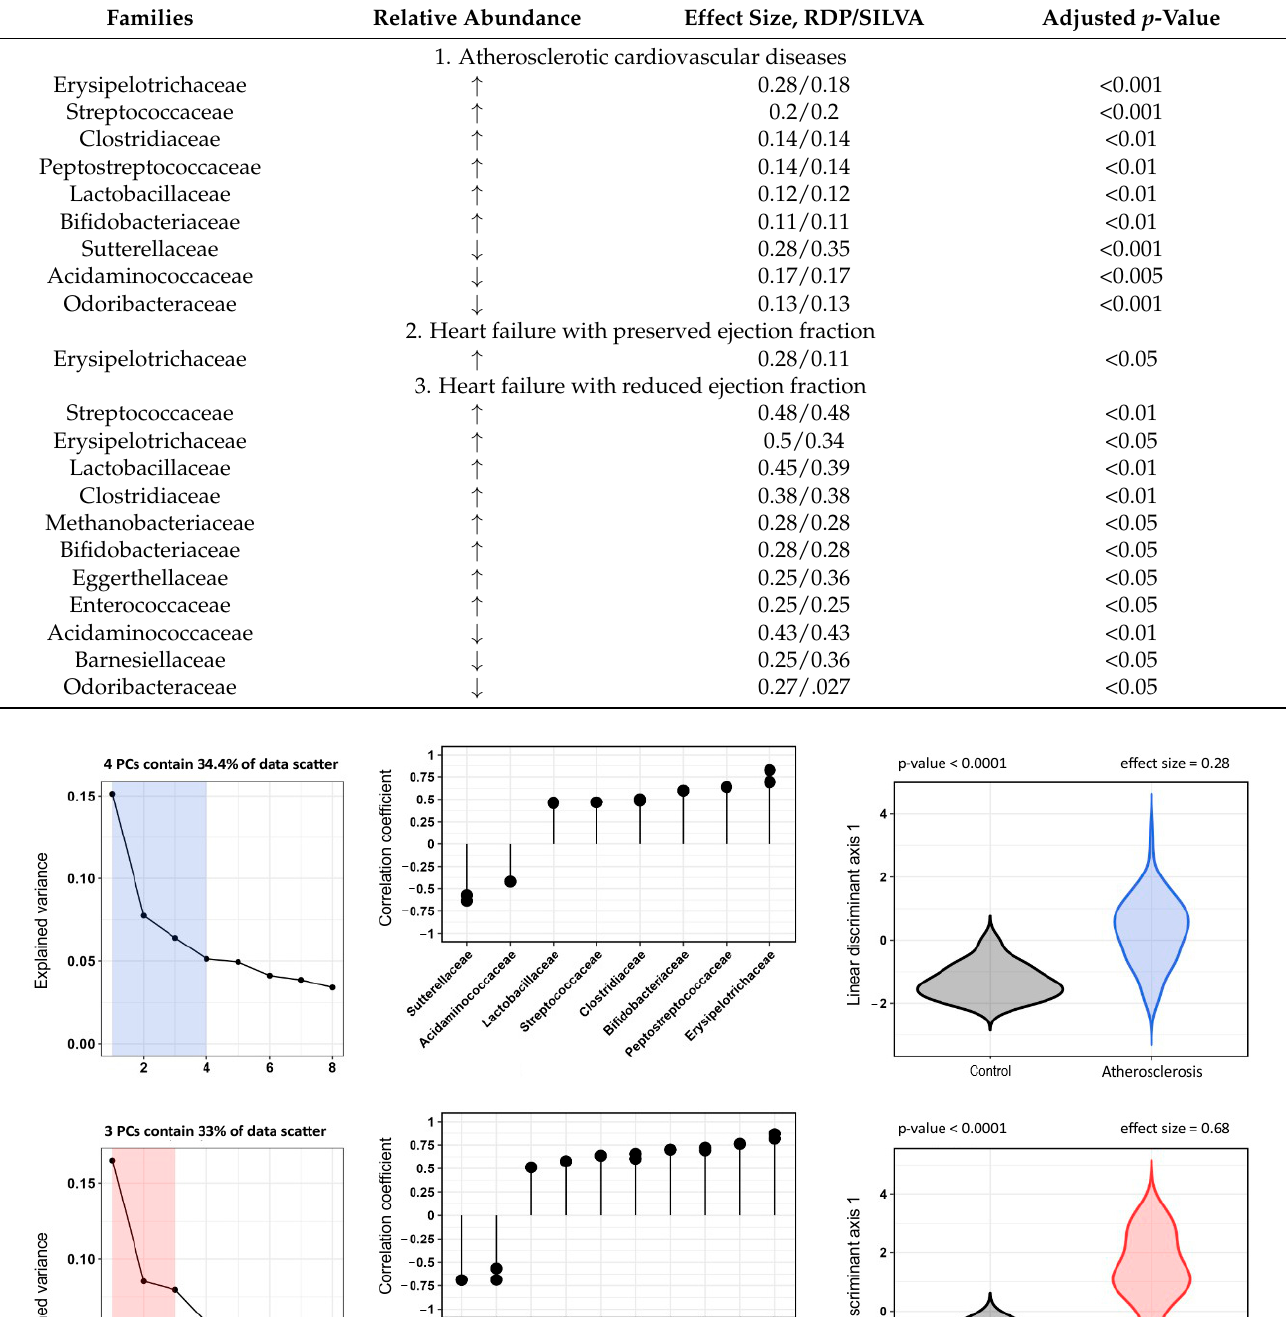
Table 7. Results of 16S RNA sequencing analysis. Arrows indicate increase ( ↑ ) or decrease ( ↓ ) in the patients group.